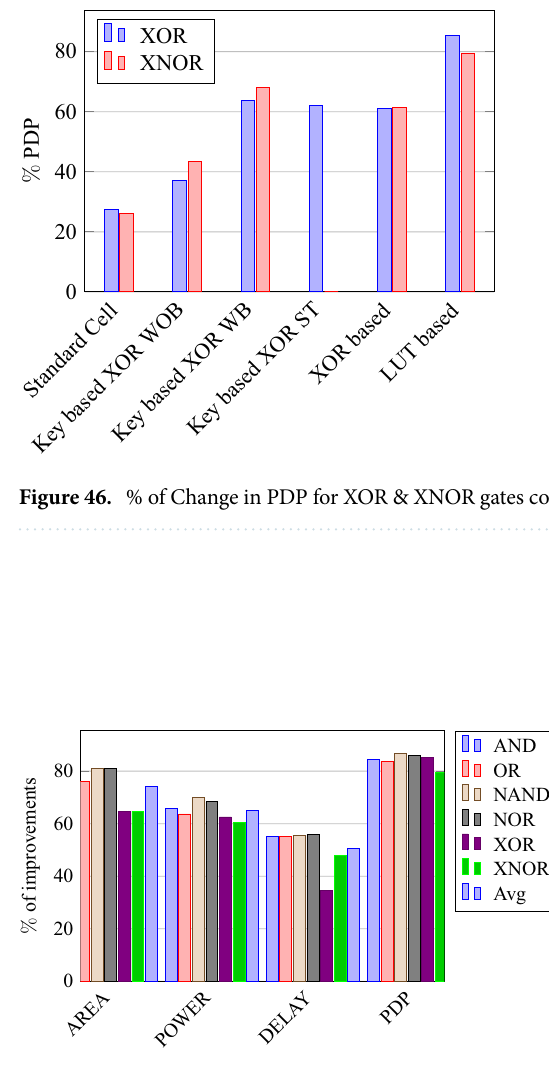
Figure 47. % of LUT overhead over the proposed